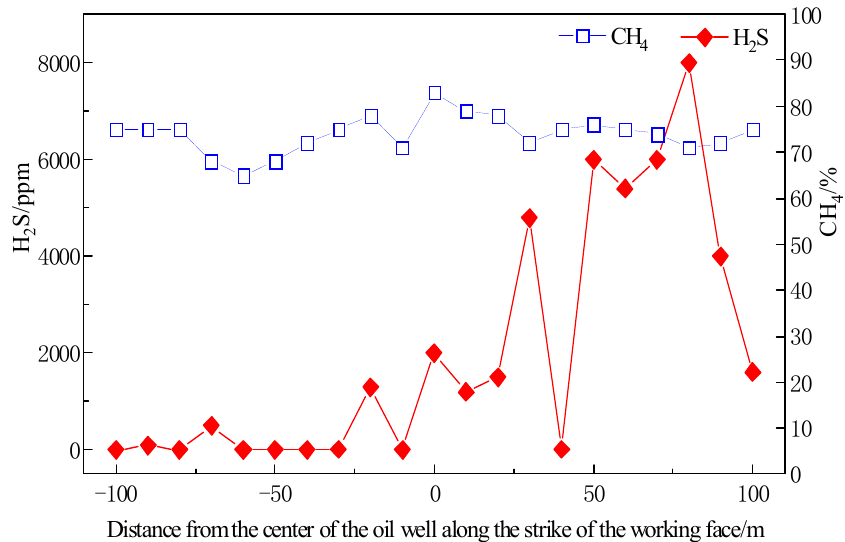
Figure 7. Distribution law of gas concentration in each borehole at the side of the transportation road in I0104 1 05 working face.